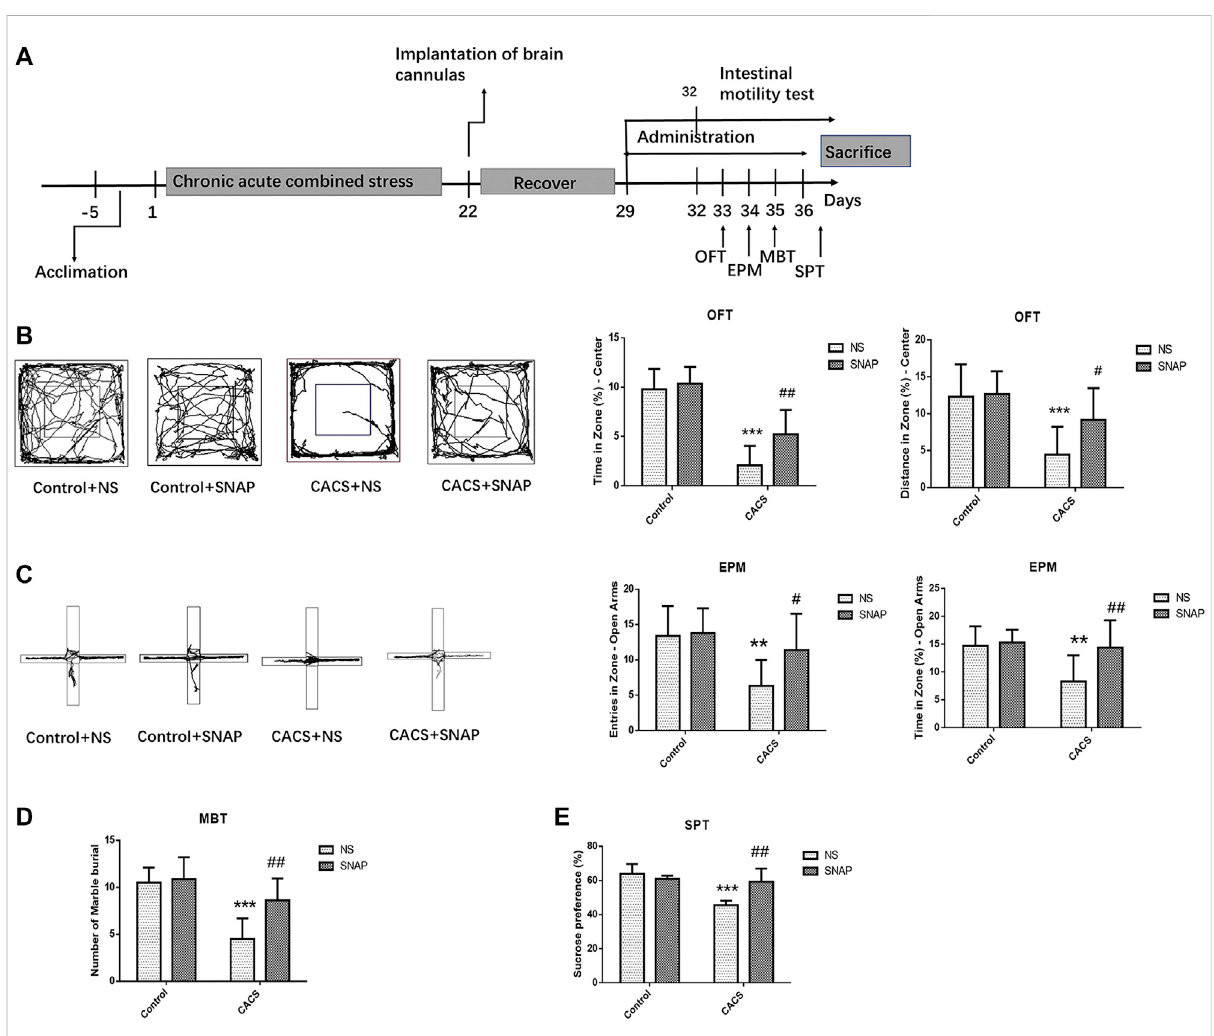
FIGURE 5 SNAP microinjection into the BLA affected the anxiety-like behaviors of CACS mice. (A) The timeline of Experiment 5. (B,C,D,E) Representative tracesoflocomotoractivityintheOFT (B) (left),EPM (C) (left),theeffectsofmicroinjectionofSNAPintotheBLAoftheCACSmodelmiceontheOFT centerresidence time anddistance (B) , EPMopen armentry times and residence time (C) , thenumber ofmarblesburiedintheMBT (D) , andsucrose preference (E) .Thedataarepresentedasthemean±SEM( n =6 – 10micepergroup).* p < 0.05,** p < 0.01,*** p < 0.001versustheControl+NS group, # p < 0.05, ## p < 0.01, ### p < 0.001 versus the CACS + NS